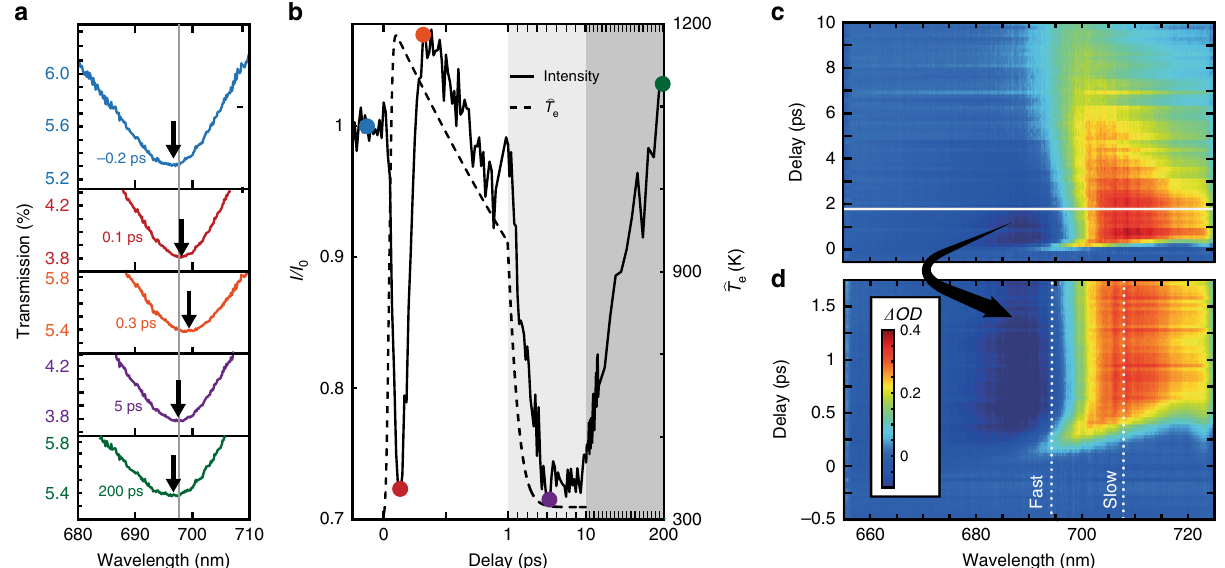
Fig. 2 Transient optical properties of the nanorod metamaterial. Transient transmission spectra measured at a 45° angle of incidence through the nanorod metamaterial when illuminated with a 70-fs control light pulse, centred at a wavelength of 585 nm with a peak power density of 16 GWcm − 2 . a Transmission spectra of TM polarised signal light through the nanorod metamaterial measured for the different delay times. Arrows indicate the shifting resonance on control light illumination, with grey line indicating the monitored wavelength plotted in b . b Intensity ( I/I 0 ) of signal light with a wavelength of 697 nm at different delay times. Coloured markers indicate the times shown in a with the greyed regions indicating longer time scales (please note a changing x -axis scale). The dashed line is the simulated homogeneous temperature b T of the electron gas after control pulse illumination. c The transient e dynamics of the optical density ( Δ OD) of the metamaterial from − 0.5 to 10 ps. d High temporal resolution zoom of the sub-picosecond dynamics around the coincidence time of the control and signal pulse (below thin horizontal white line in c ). Regions with fast and slow transmission variations are indicated with vertical white dashed